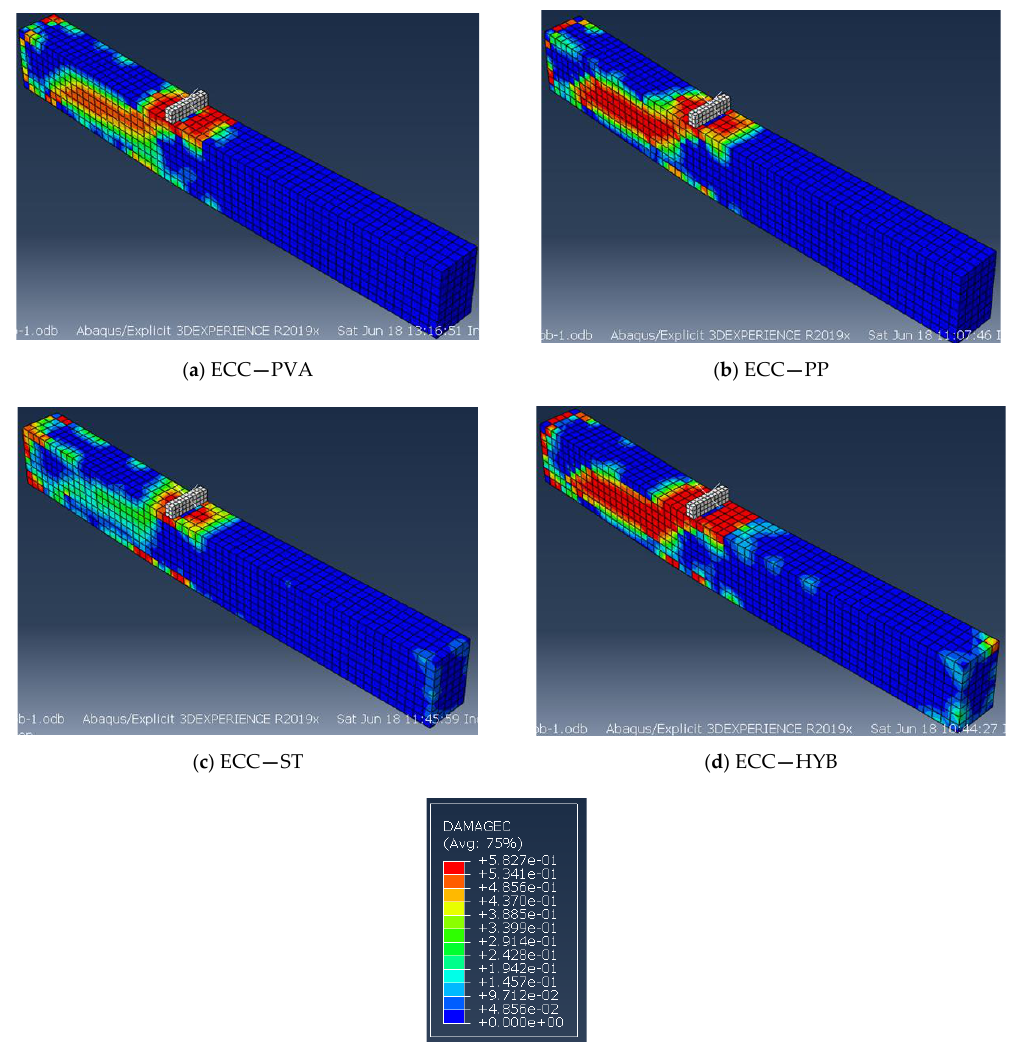
Figure 10. Crack pattern and failure mode of ECC specimens from FE analysis: ( a ) ECC — PVA, ( b ) ECC — PP, ( c ) ECC — ST, ( d ) ECC — HYB, ( e ) hybrid PVA + PP effects.